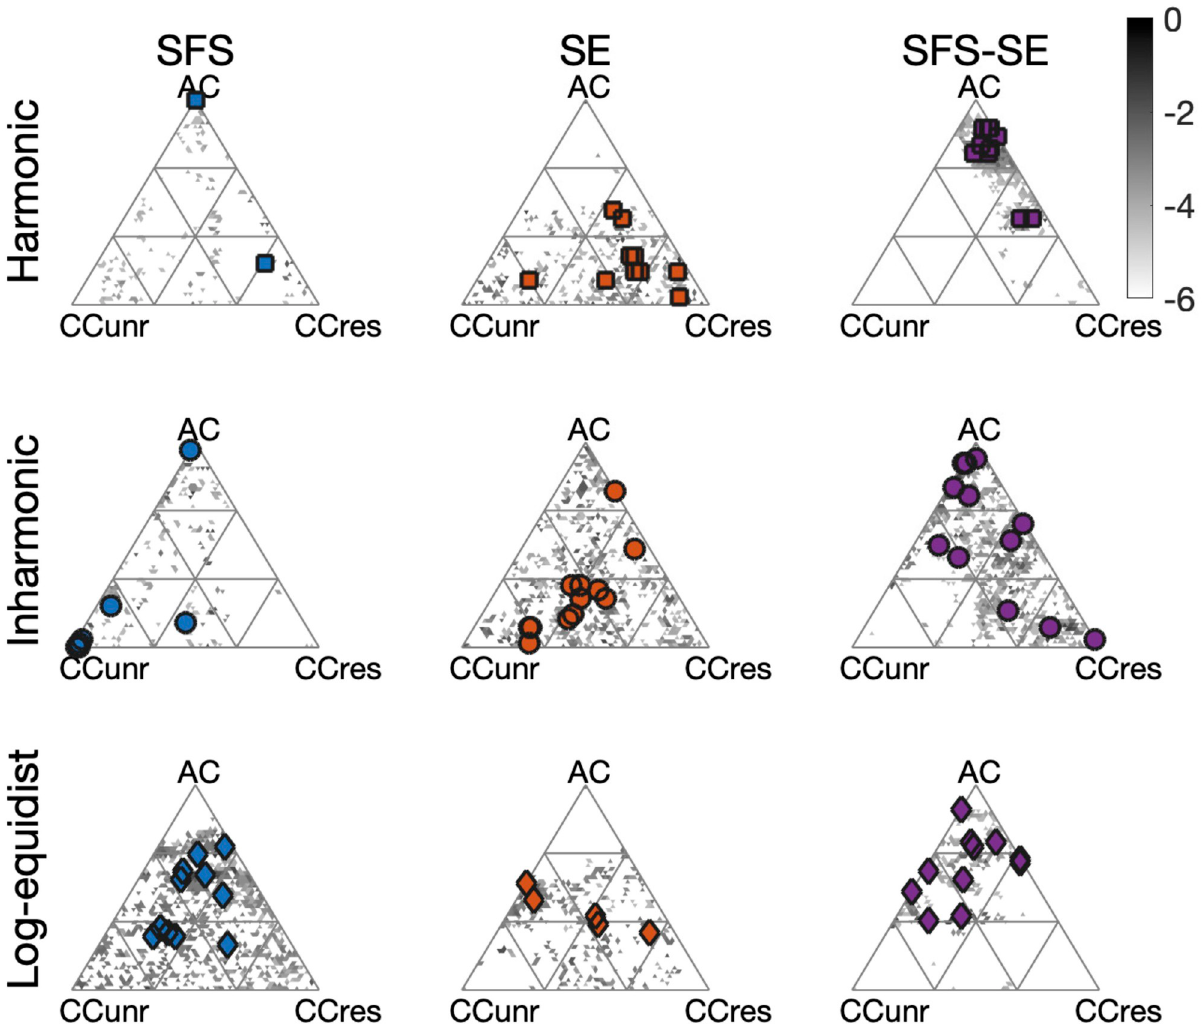
Fig 8. Cue weights for all conditions and participants with panels sorted as in Fig 7. Constrained to sum up to one, cue weights live on a two- dimensional hyperplane with triangular borders. Points in the triangular space correspond to weightings of the three cues AC, CCres, and CCunres (weights sum up to one). Large symbols correspond to the medians of the optimal weighting for individual listeners as computed from 2000 bootstrap iterations. Gray symbols highlight spread of bootstrap samples (the darker, the more overlap from different bootstrap iterations; specifically plotting log10 of the empirical density function of the bootstrap